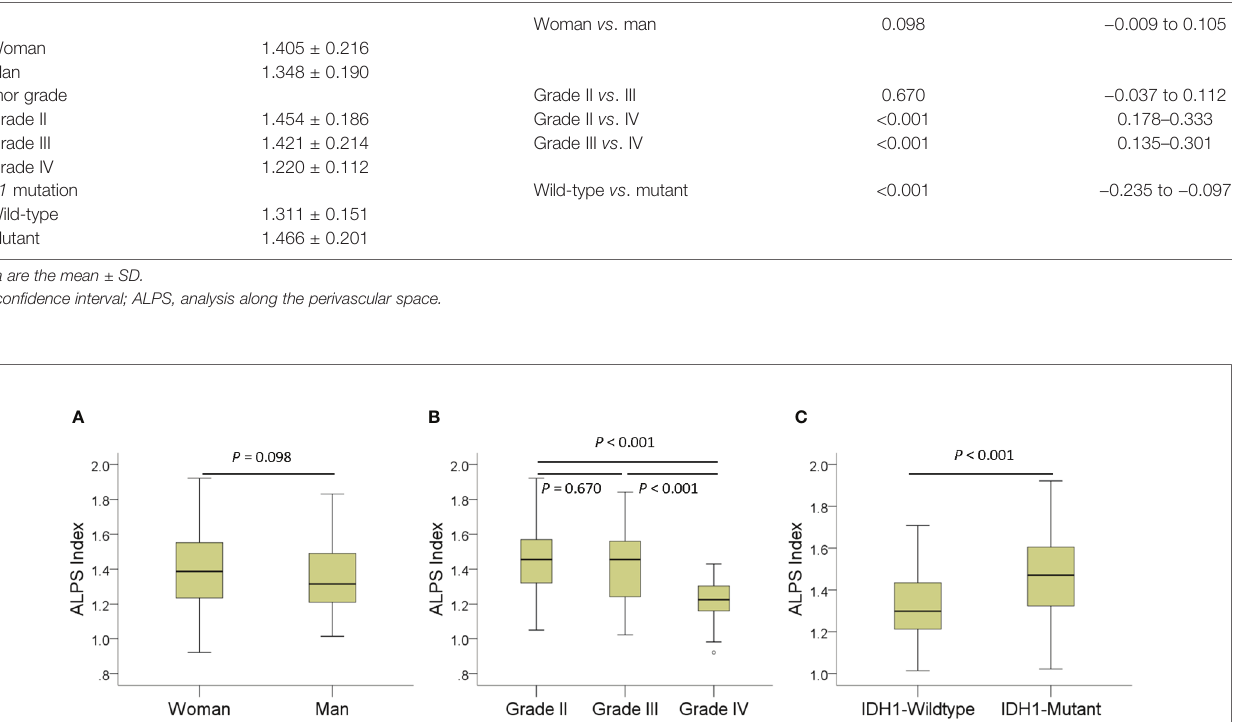
TABLE 2 | Comparisons of the ALPS index according to sex, tumor grade, and IDH1 mutation status with age adjustment. Characteristics